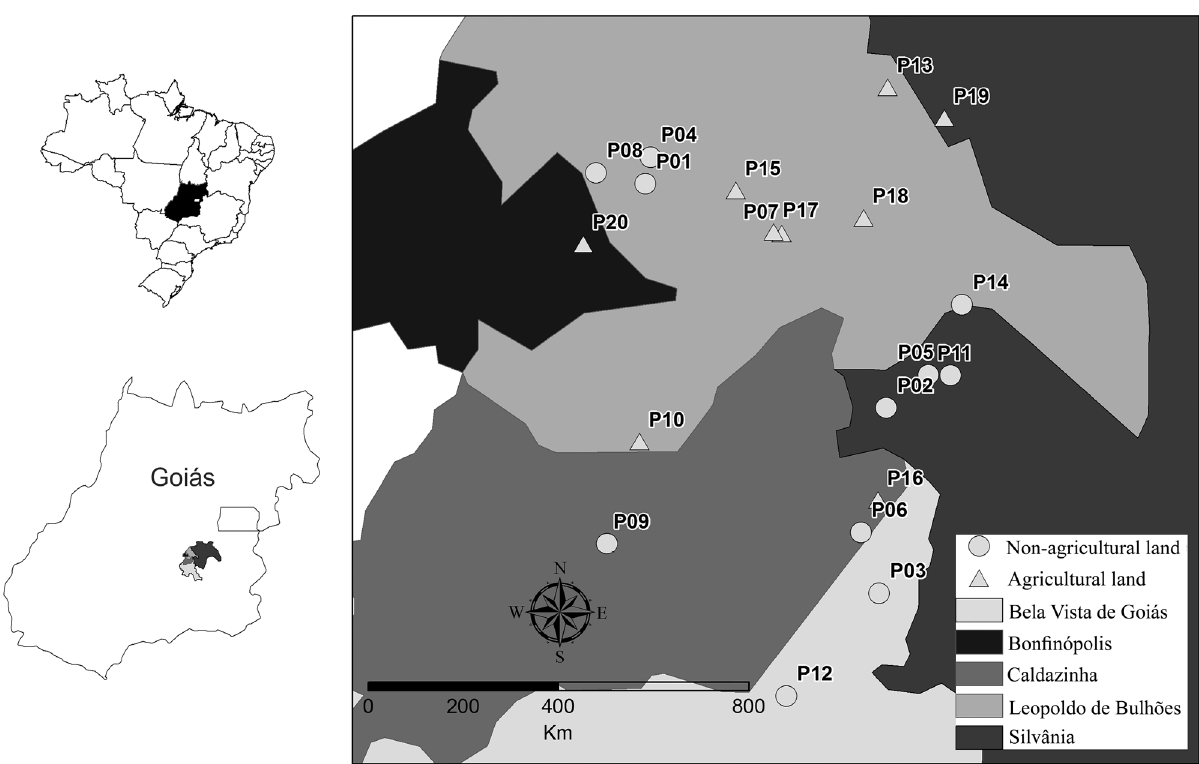
Figure 1. Spatial distribution of the ponds sampled at five municipalities in the state of Goiás. cultural activities had taken place in the last six months. Table 1 represents the sampled areas for tadpoles, and the pesticides used according to information provided by the farmers, from November 2013 to January 2014. We quantified the percentage of non-natural areas around each pond with a buffer radius of 480m, using the ArcGIS